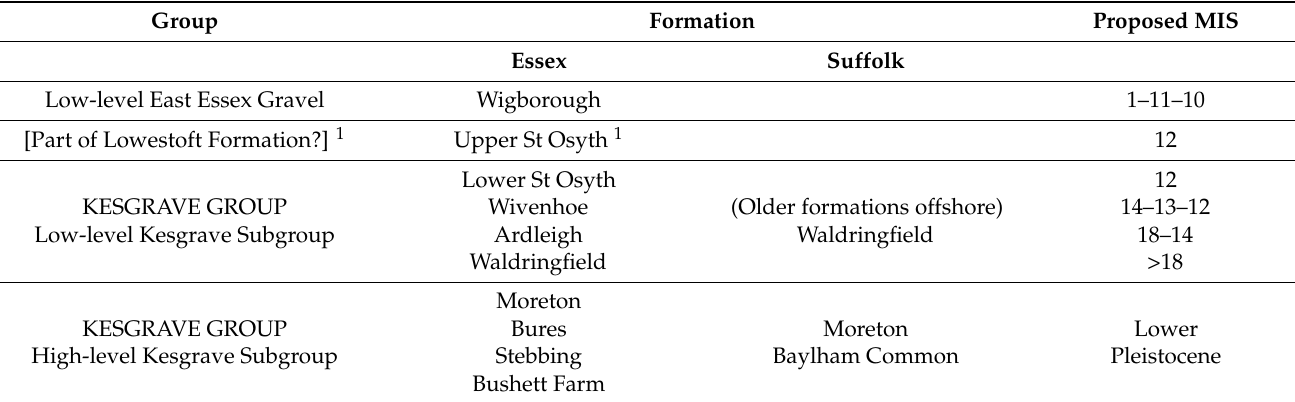
Figure 5. Idealized transverse section through the pre-diversion terraces of the River Thames in southern East Anglia, after [36]. Note the greater complexity of palaeosols capping progressively higher terraces [37]. Interglacial deposits interbedded with the cold-climate terrace gravels on the Tendring Peninsula are indicated. Proposed MIS correlations are indicated in roundels, red for interglacials and blue for glacials. Table 1. The Thames terrace sequence in Essex and Suffolk [9,31,38].